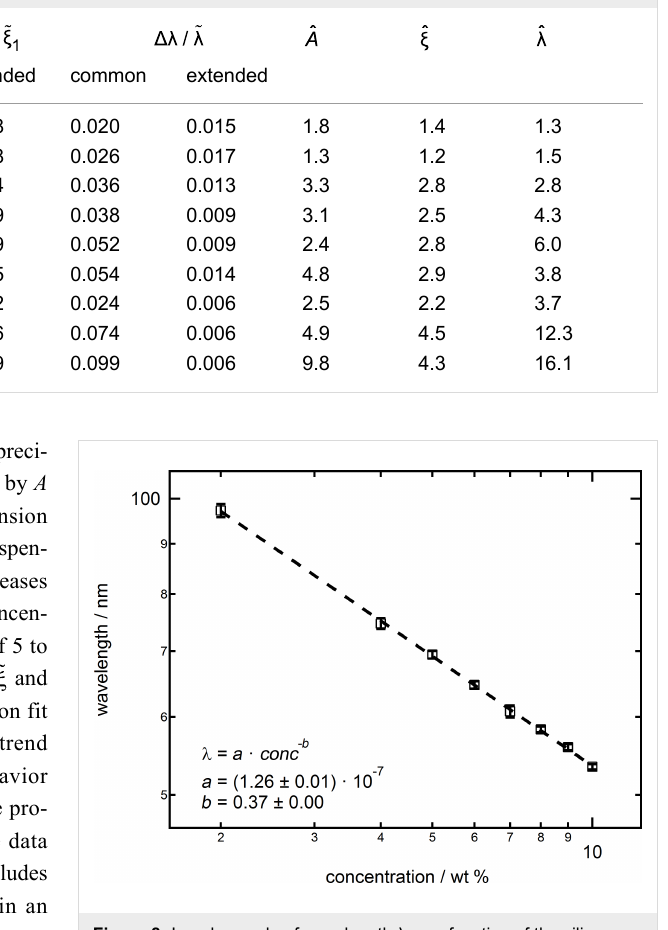
Figure 8: Log–log scale of wavelength λ as a function of the silica nanoparticle concentration and the respective fit by a power law.